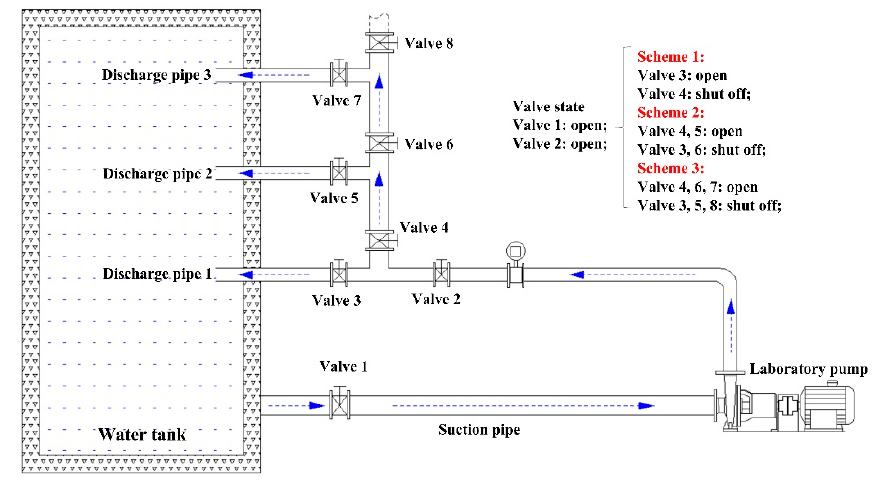
Figure 2. The test rig of three different discharge piping schemes.